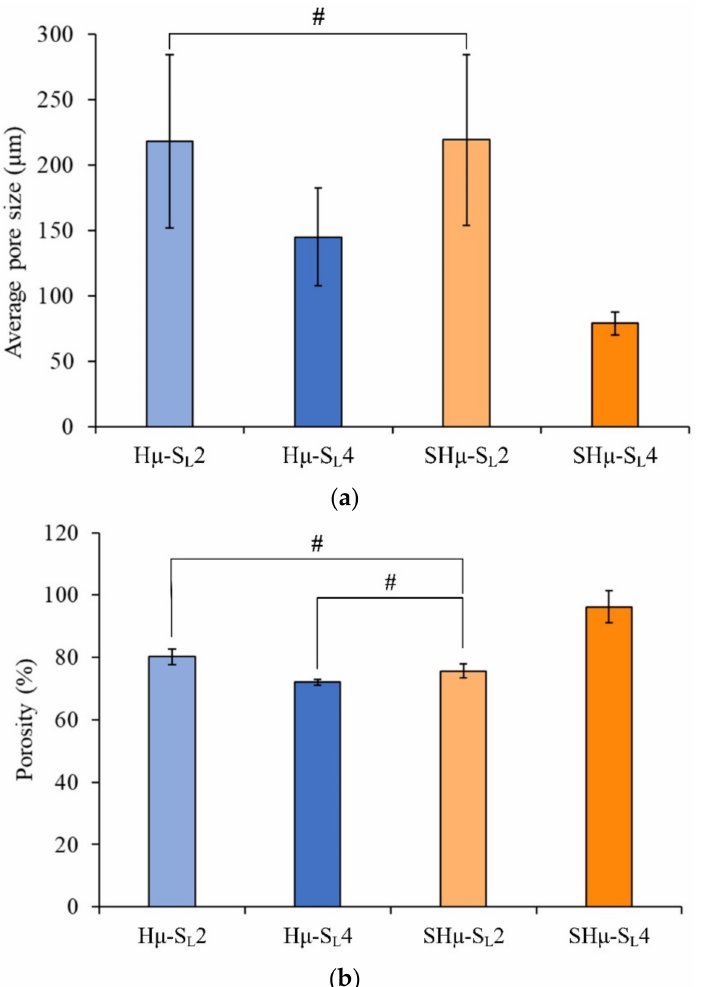
Figure 2. Hydrogel scaffolds prepared by impregnating different proportions of the pore former: ( a ) average pore size ( n = 20) and ( b ) porosity ( n = 5). # indicates that the groups are not significantly different after the comparison ( p >